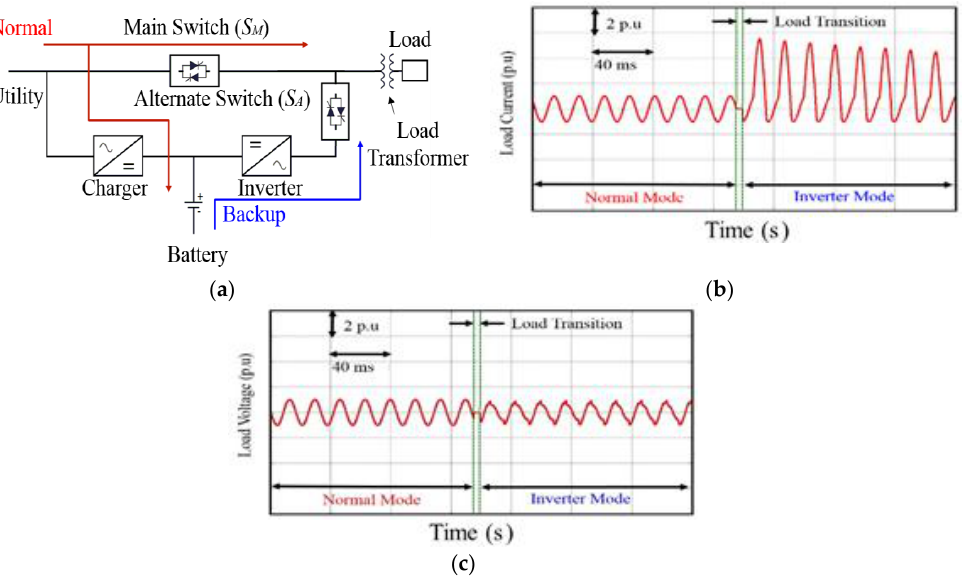
Figure 2. ( a ) Basic diagram of a single-phase offline UPS system with load transformer; ( b ) load current; and ( c ) load voltage.